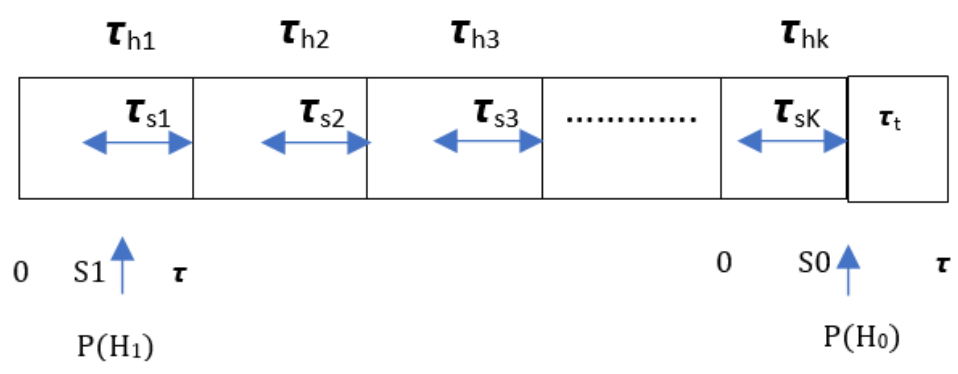
Figure 2. Frame structure with the states of the ST.